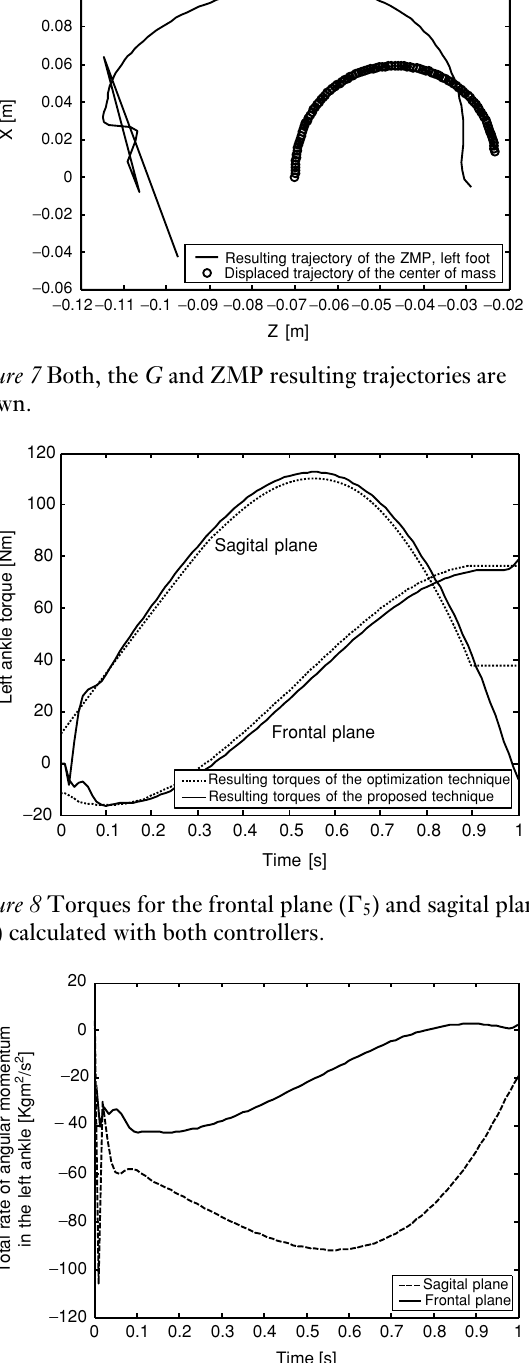
Figure 9 The values of δ P for the sagital and frontal plane for the left ankle. Incontrast,theproposedtechniqueprovidesthetorques during the whole trajectory, keeping the balance of the biped robot. Figure 9 shows what happens with the total rate of angular momentum ( δ P ). The reference value for δ P used in the simulation phase was